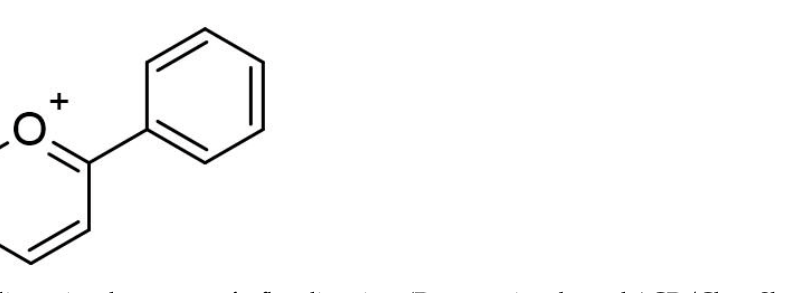
Figure 3. Two-dimensional structure of a flavylium ion. (Drawn using the tool ACD/ChemSketch, version 2021.2.1, Advanced Chemistry Development, Inc., Toronto, ON, Canada).